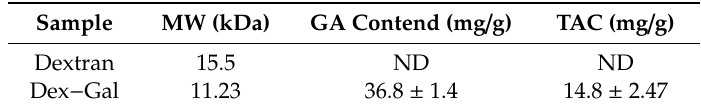
Table 1. Molecular weight (MW), Gallic Acid (GA) content, and total antioxidant activity (TAC) of dextran and dextran–gallic acid